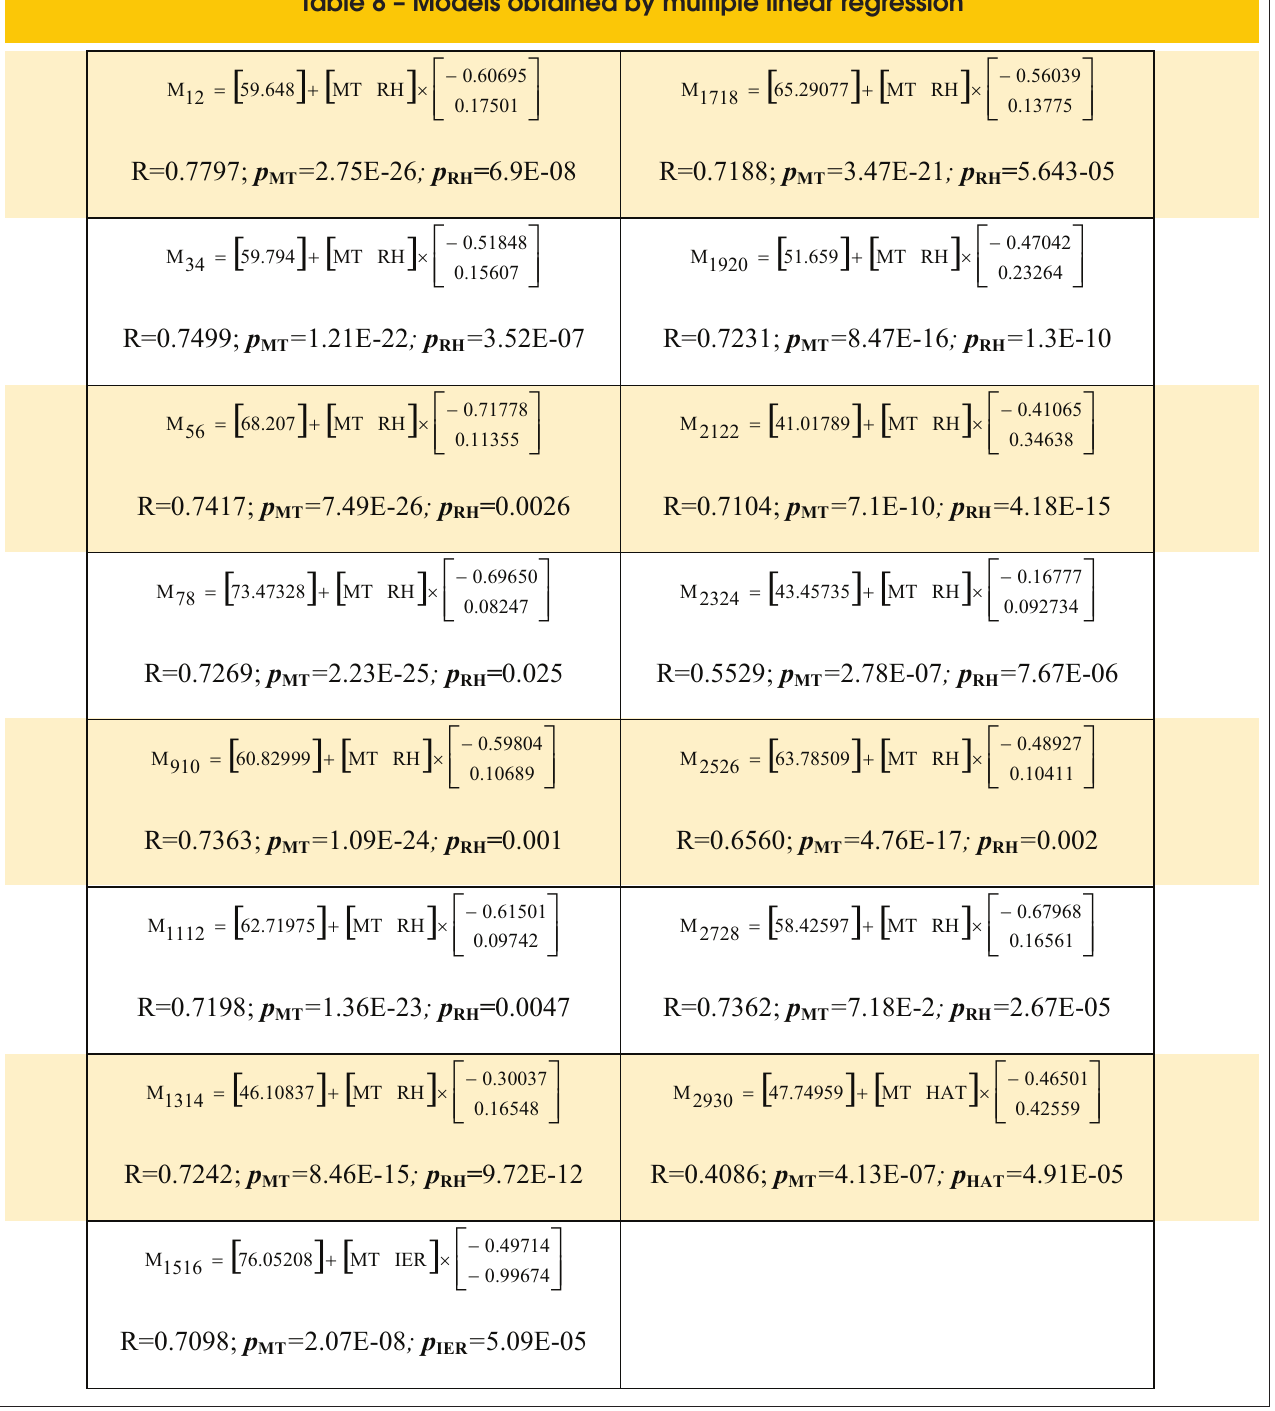
Table 8 – Models obtained by multiple linear